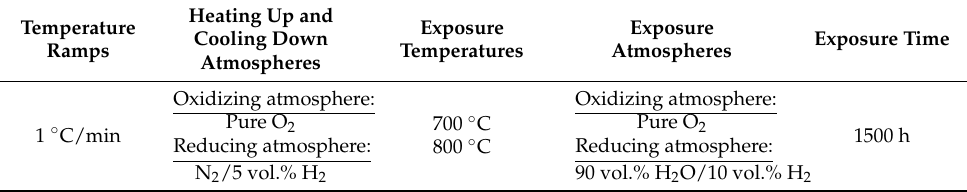
Table 2. Parameters for oxidation tests.